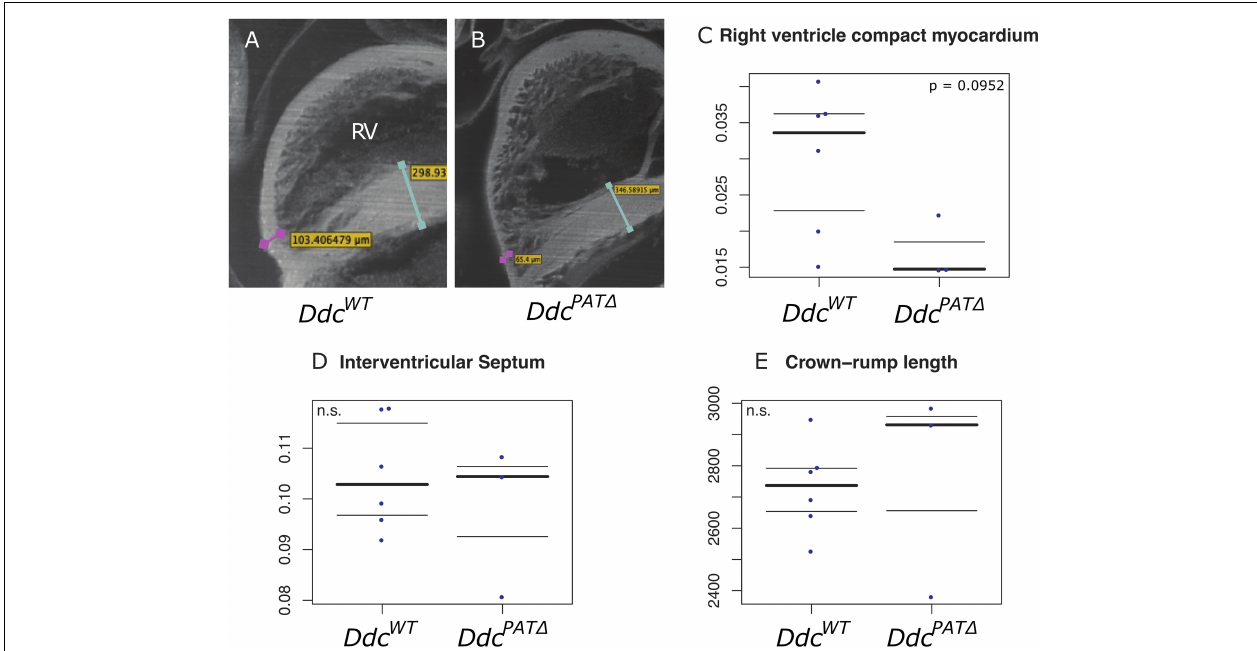
FIGURE 3 | Morphological analysis of Ddc knockout hearts. Episcopic fluorescence image capture measurements of wildtype Ddc WT and Ddc PAT (cid:49) knockout E15.5 mouse heart regions using embedded, sequentially sectioned hearts built into a 3D model using the VelocityTM software. Visualization of the 3D ventricles depicting where the measurements were made in (A) Ddc WT and (B) Ddc PAT (cid:49) embryos. The thickness of the right ventricle (RV) compact myocardium at the apical point parallel to the interventricular septum (IVS) is shown by the pink bar in (A) and pink bar in (B) . The IVS measured at the widest point is indicated by the turquoise bar in (A) and the turquoise bar in (B) . All measurements were adjusted to crown rump length to control for embryo size variation (C–E) . A thinning of the compact layer in the right ventricle is suggested (C) in knockout animal hearts compared to wild type with no change in the width of the IVS (D) or crown-rump length (E) but the total numbers of embryos studied was not sufficient to show statistical significance.